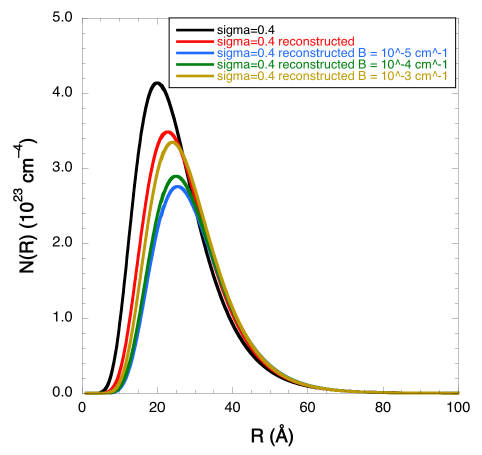
Figure 8. SDFs reconstructed with the parameters ( N o , R o , and σ ) calculated with the SPA for the case σ = 0.4 without (red line) and with additional backgrounds of 1.0 × 10 − 5 (B1—blue line), 1.0 × 10 − 4 (B2—green line), and 1.0 × 10 − 3 cm − 1 (B3—yellow line). The original SDF is also shown for comparison (black